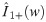
Validation of Eq (62).Absolute value I^1+(w) in log10 scale for −4π < Re[w] < 0, on the bottom the relative error in log10 scale obtained from the approximate expression of I^1+(w) given by Eq (62) while substituting the exact expression of V^1d(w) (73) of [8] and performing the numerical integration. [Φa,Φb,φo]=[0.18¯π,1.2π,0.1π]. The colors at the bottom delimits zone with relative errors lower than 10−14 (dark blue), lower than 10−12 (blue) and lower than 10−11 (light blue).